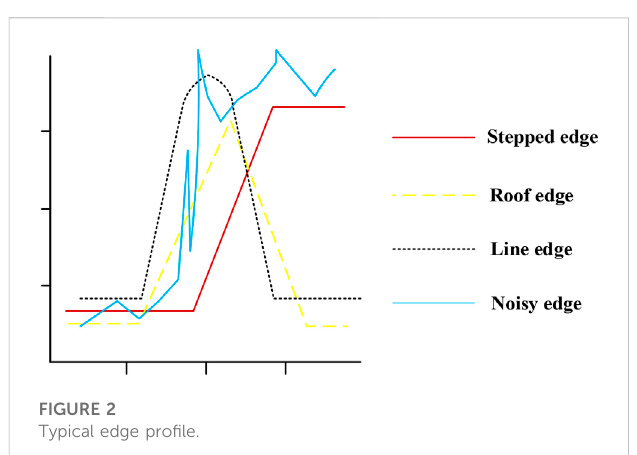
FIGURE 2 Typical edge pro fi